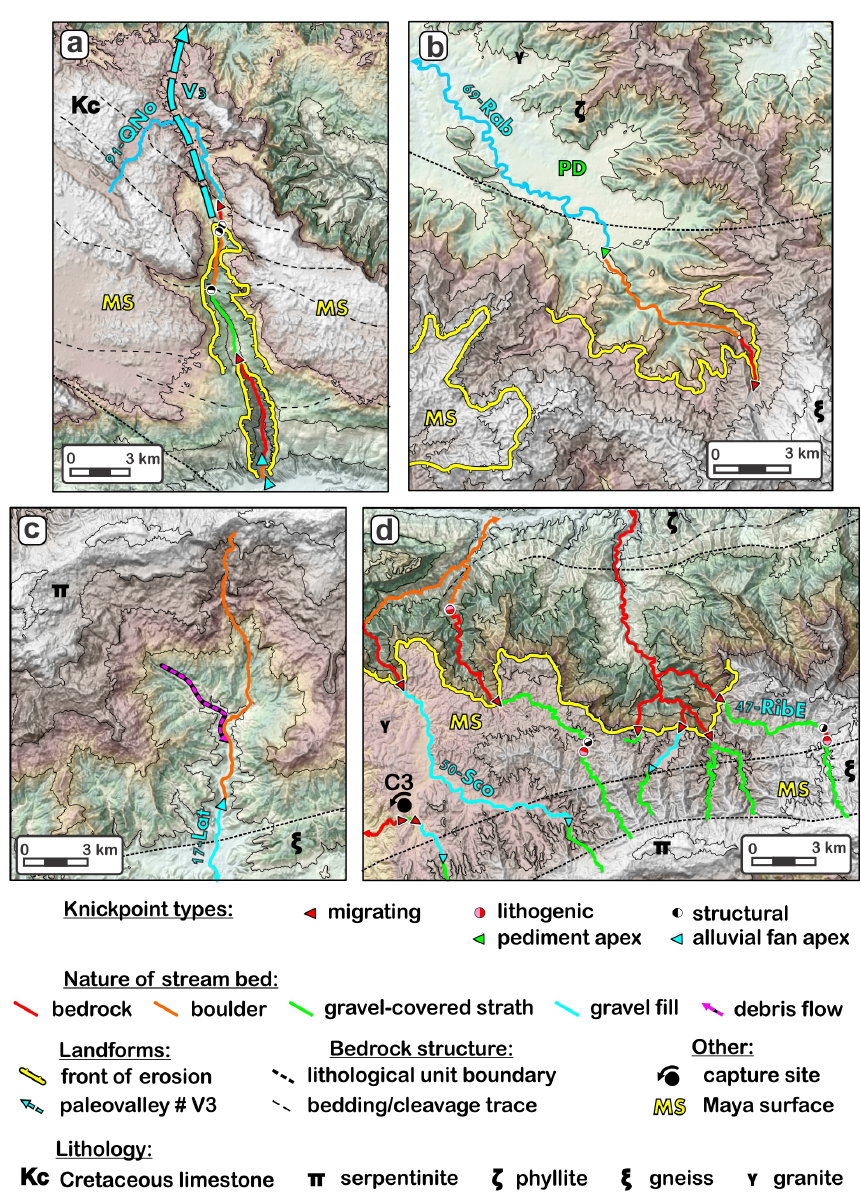
Figure 8. Examples of some knickpoint types presented in their geomorphic setting. Shaded and sloped 30m resolution ALOS DEM©JAXA. Location of maps A–D in Fig. 7. (a) Valley of the Quilén Novillo–Chancol rivers (91-QNo, AC Range), showing the pa- leovalley V3 (Fig. 2), shallowly incised into the Maya surface (Brocard et al., 2011), and two imbricate waves of erosion migrating up the reversed (southward-directed) drainage of the valley. (b) Typical stepped topography of the SC range in the catchment of the Rabinal river (69-Rab), showing three imbricate upstream-migrating erosive signals distributed along the mountain slope. The upper one is a wave of erosion that dissects the Maya surface, a second one is located halfway down the mountain flank, and the basal and final wave is located at the base of the range at the apex of pediments (PD). (c) Diffusive erosion in serpentinite mélanges, in the catchment of Río Hato (17-Lat, SM Range). (d) Dissection of the Maya surface by prominent migrating knickpoints along the northern flank of the SM Range, from the Ribaco River to the Chilasco River (47-Rib to 50Sco). C3 indicates a 200kyr old avulsion site (Brocard et al., 2012).